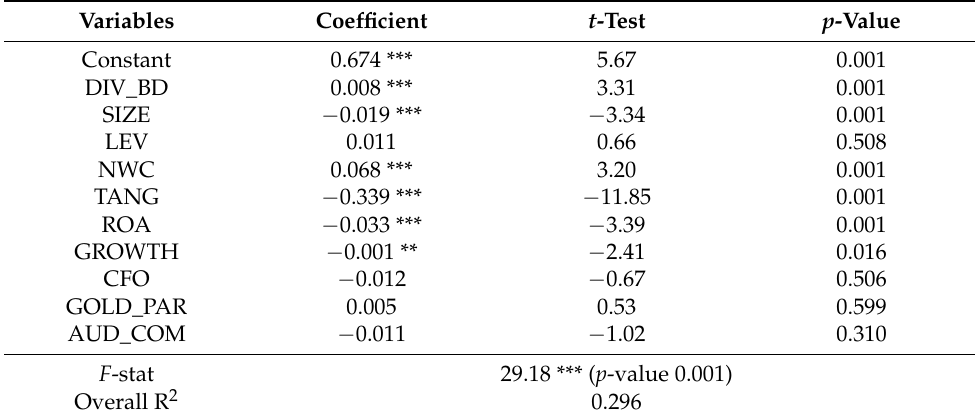
Table 4. Fixed-effect regression results of the main